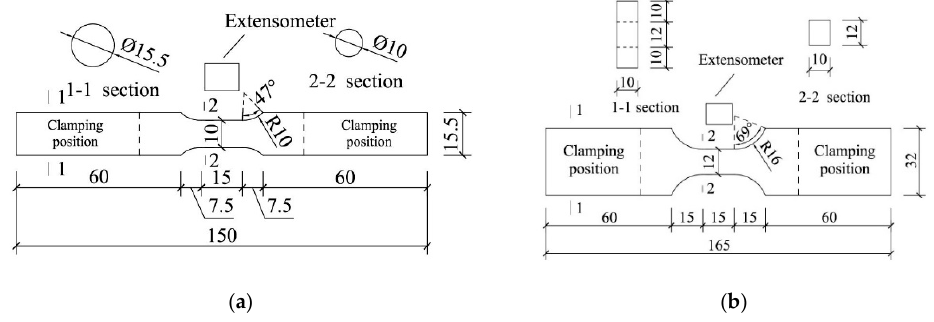
Figure 1. Dimensions of specimens. ( a ) Q235 and Q345; ( b ) S304 and S316.